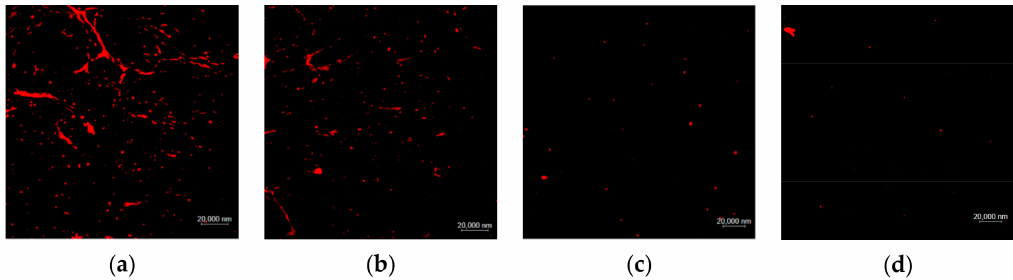
Figure 6. The releasing of protamine–siRNA complexes from the TSPMAHs at di ff erent temperatures.